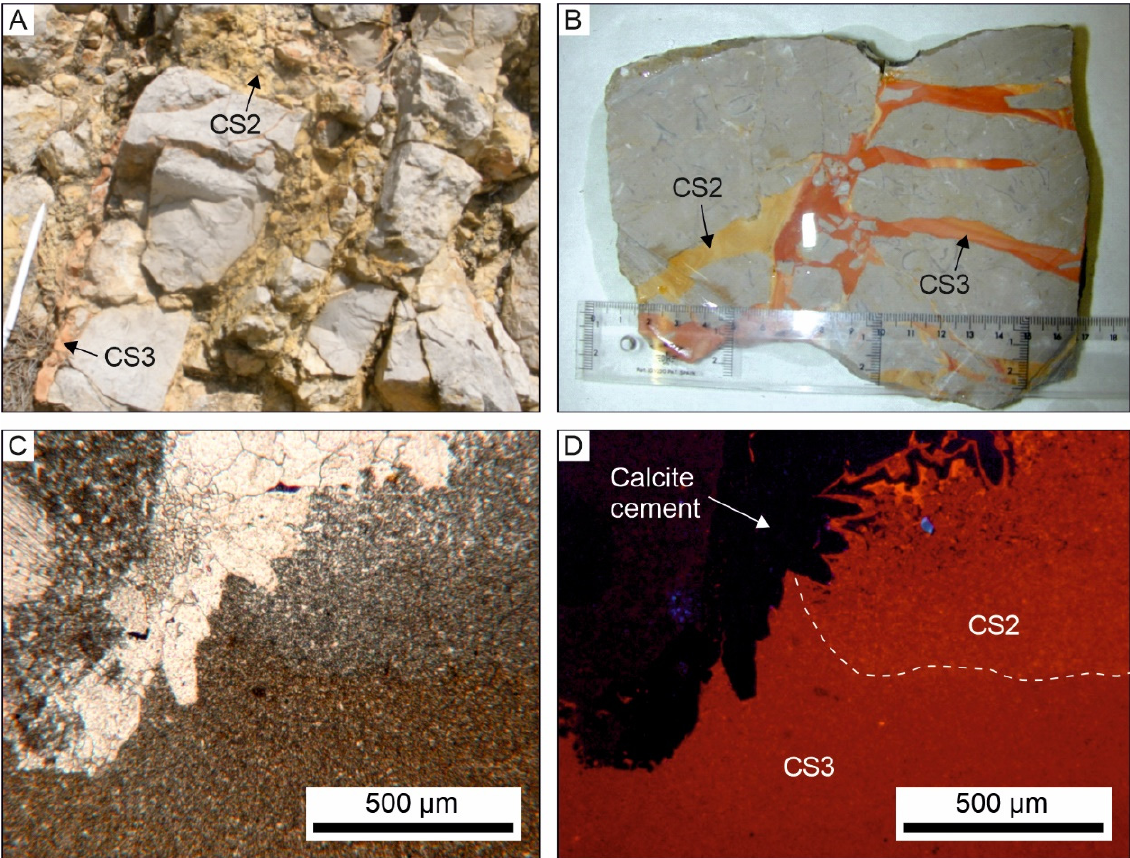
Figure 8. Main features of Lower Cretaceous host limestones, CS2 and CS3 karst fills in the Olèrdola outcrop. ( A , B ) Field photograph of CS2 and CS3 within fractures in Lower Cretaceous limestones. ( C , D ) Optical (plane polarised light) and cathodoluminescence image of the relationships between CS2, CS3 and calcite cement. Note the microsparite and micrite textures of CS2 and CS3, respectively.